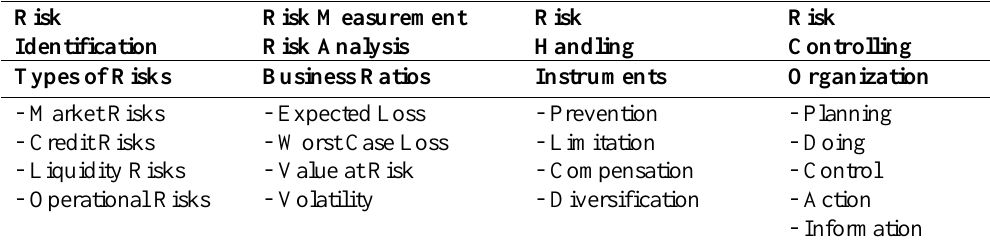
Table 1. Process of Financial